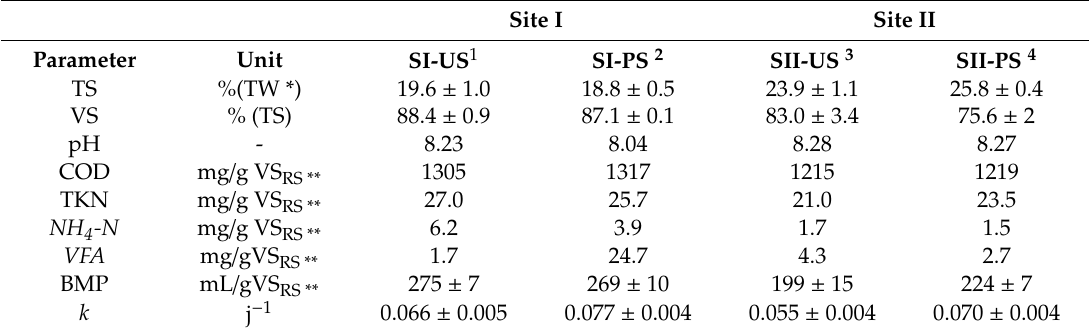
Table 1. Physical and biochemical characteristics of untreated and pretreated